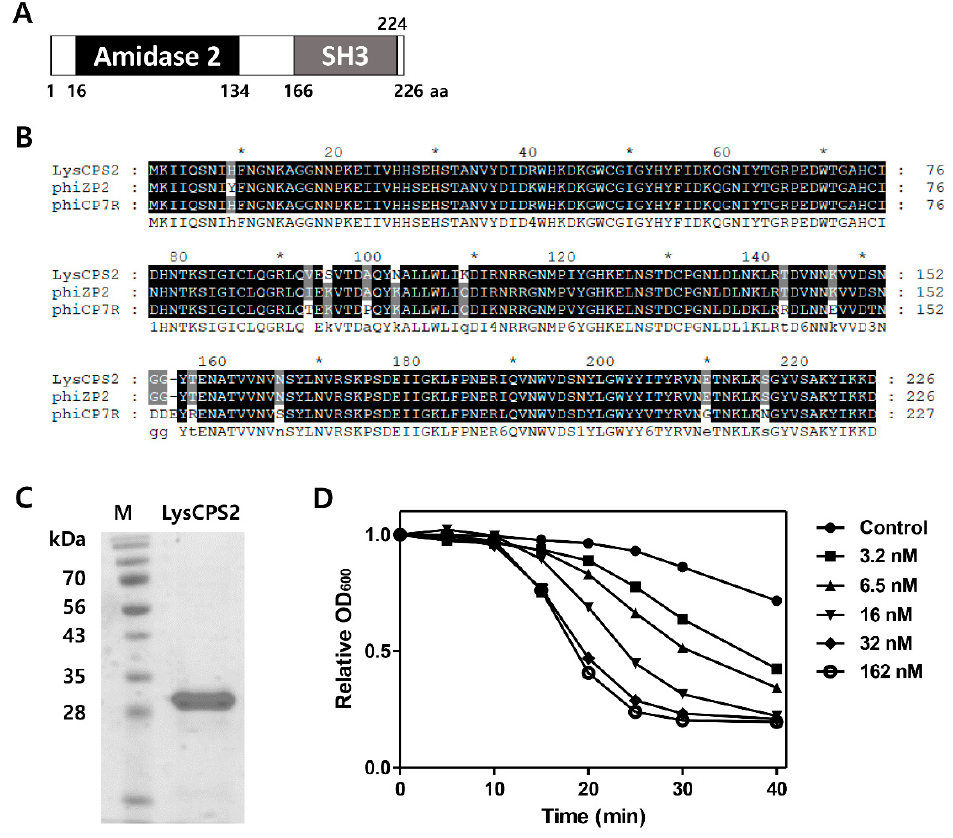
Figure 2. Modular structure and lytic activities of the LysCPS2 endolysin from CPS2. ( A ) Schematic representation of LysCPS2. The conserved amidase2 domain is shown; ( B ) Sequence alignment of various Clostridial phage endolysins; CPS2 phage endolysin, phiZP2 phage endolysin, phiCP7R phage endolysin; ( C ) SDS-PAGE analysis of purified LysCPS2. M: standard molecular weight marker, LysCPS2: purified LysCPS2 fraction; ( D ) Lysis of C. perfringens ATCC 13124 cells treated externally